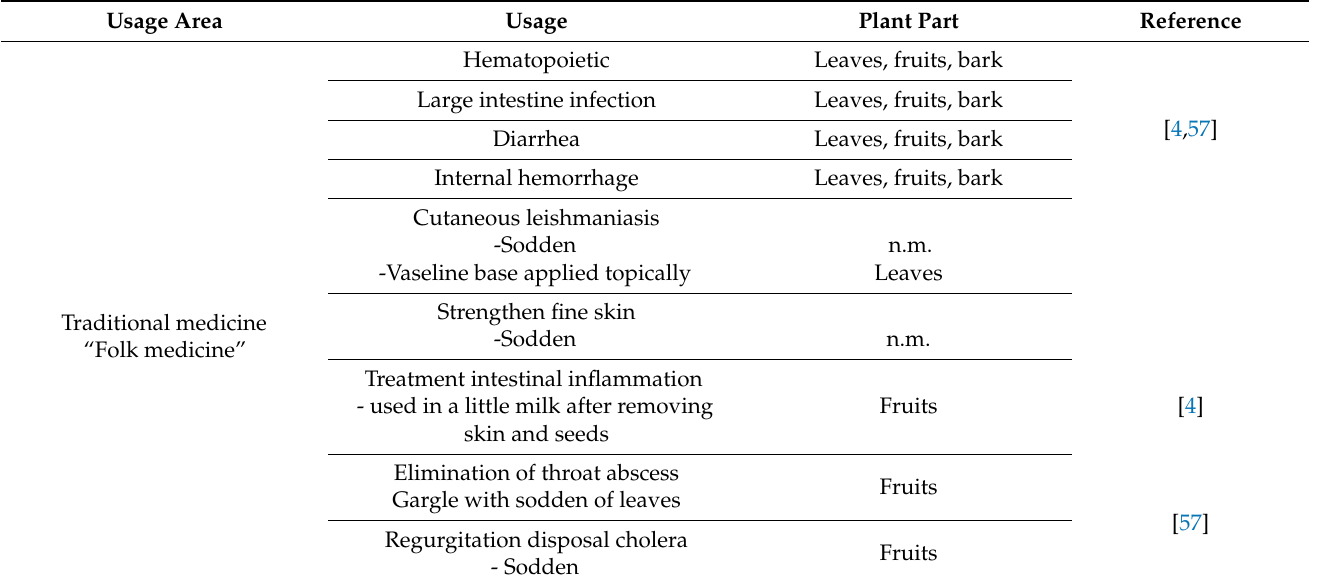
Table 14. Different possibilities of Mespilus germanica L. usage. Usage